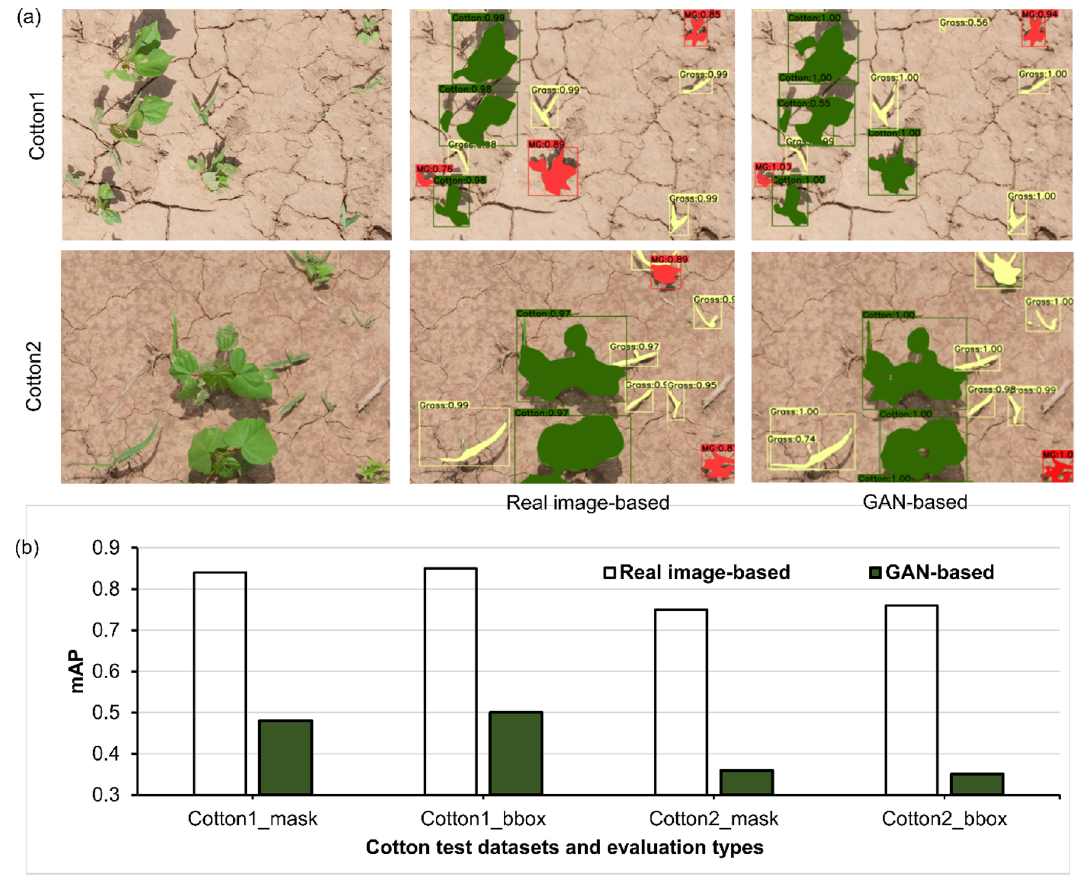
Figure 8. Results obtained from models trained with synthetic images generated using real plant instances and generative adversarial network (GAN)-derived fake plants: ( a ) Detection and segmentation results obtained for the test datasets Cotton1 and Cotton2, and ( b ) Mean average precision (mAP) values for bounding box (bbox) and mask results obtained for Cotton1 and Cotton2. Here, green, red, and yellow detected masks represent cotton, morningglories, and grass,